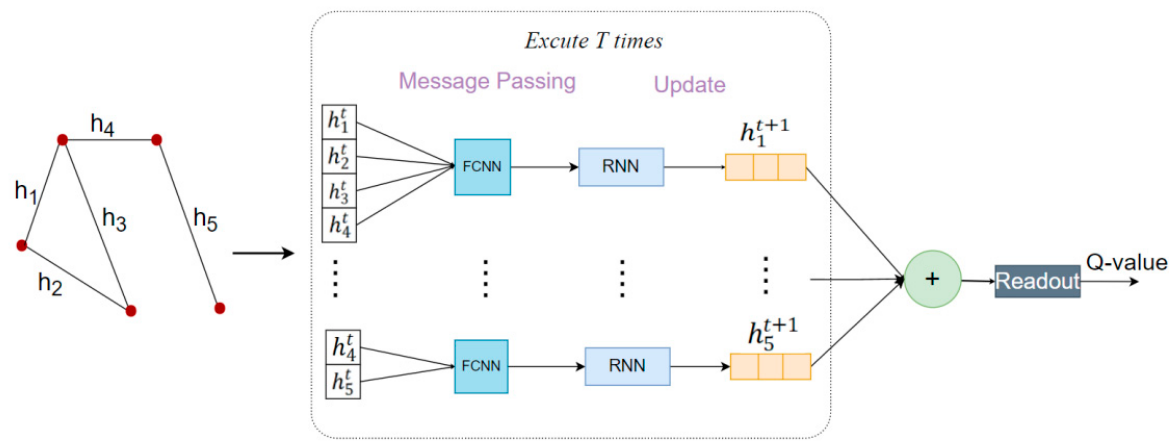
Figure 2. The MPNN Figure 2. The MPNN workflow.